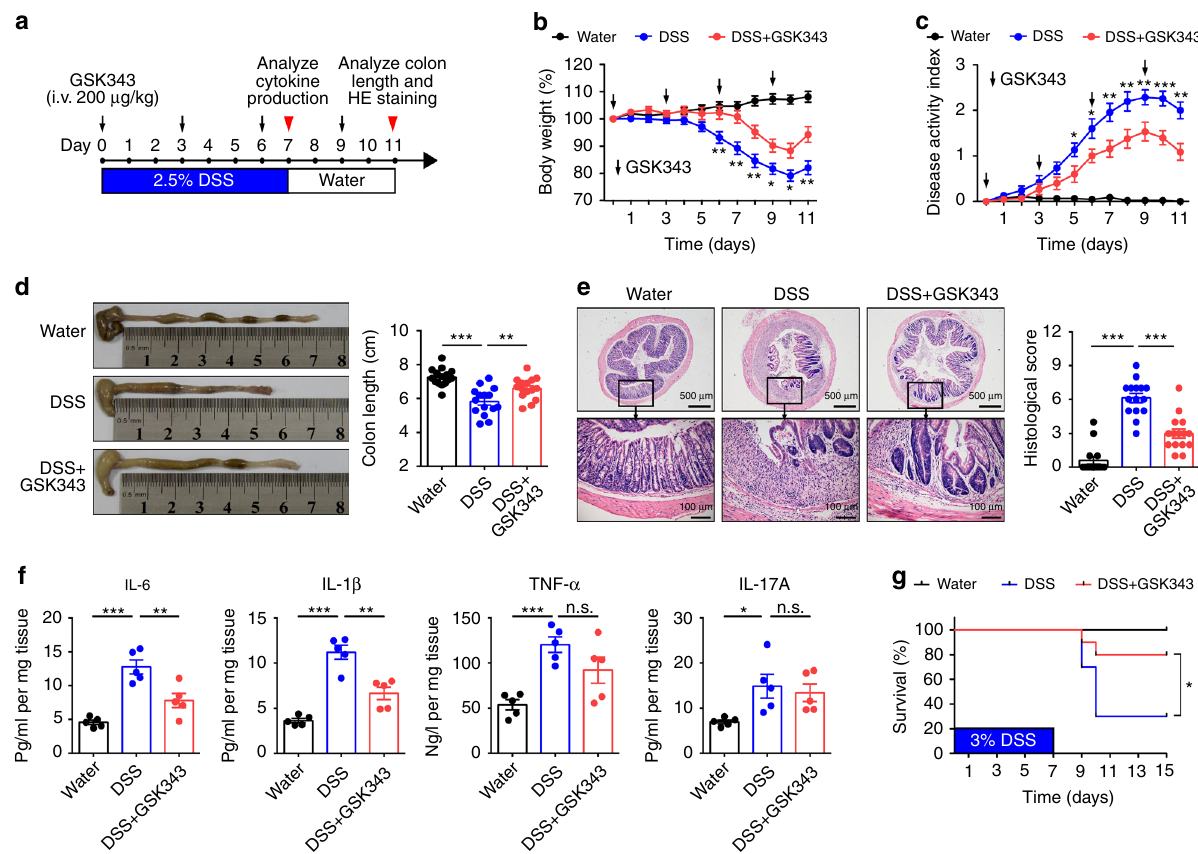
Fig. 1 Inhibition of EZH2 activity preventively ameliorates DSS colitis. a Methods for DSS-induced acute colitis in C57BL/6 mice and GSK343 administration. b , c Body weight ( b ) and disease activity index ( c ) of mice that received regular drinking water alone (Water group, black dotted line) or 2.5% DSS-containing water (DSS group, blue dotted line), or 2.5% DSS combined with GSK343 injection (DSS + GSK343 group, red dotted line) ( n = 15 per group). For statistical comparisons, asterisk indicates DSS vs. DSS + GSK343. d , e Colon length ( d ), representative hematoxylin and eosin (H&E) staining of distal colon sections, and corresponding histological scores ( e ) at day 11 after DSS induction ( n = 15 per group). f Colonic in fl ammatory cytokine analysis from distal colonic tissue at day 7 after DSS induction ( n = 5 per group). g Survival curves of mice treated with drinking water, 3% DSS, or 3% DSS plus GSK343 ( n = 10 per group). Data are representative of three independent experiments. * P < 0.05 by log-rank test. b – f Data are representative of three independent experiments. Quantitative data are shown as the mean ± SEM. The statistical signi fi cance of differences was determined by two-way